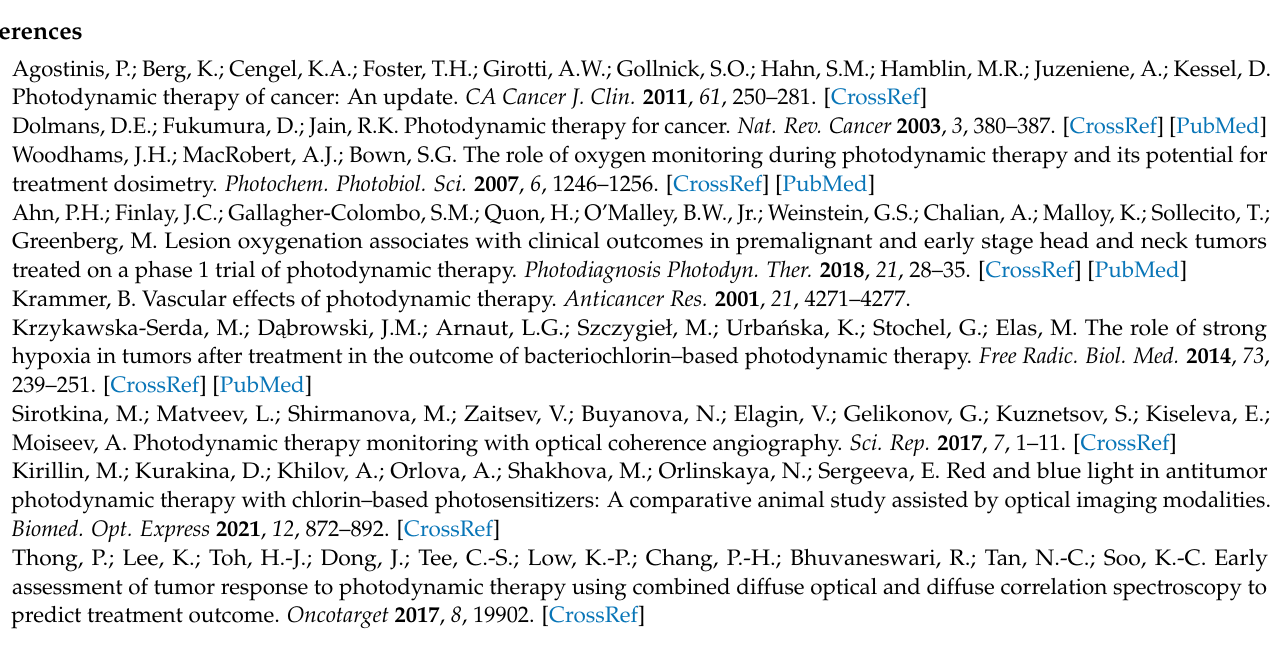
Figure A1. The ratio of the spectra taken before and after PS injection measured at the 3.5 mm source-detector separation. The graph shows no chlorin e6 absorption and emission peaks in the range 600–700